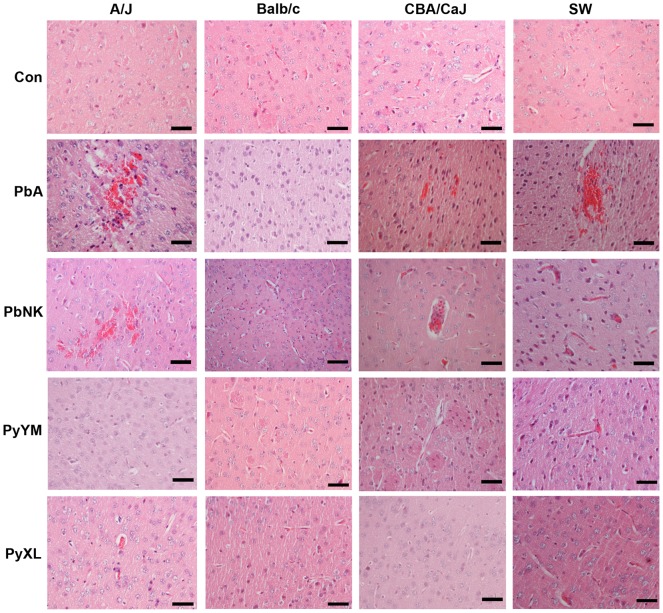
Histopathology of P. berghei and P. yoelii infection in different mouse strains.Representative images of brains from groups of 3 A/J, Balb/c, CBA/CaJ, or SW mice, infected with PbA, PbNK, PyXL, or PyYM, as well as uninfected control brains were paraffin embedded and sections stained with H&E. PbA and PbNK infection caused focal vascular congestion and hemorrhages throughout the gray and white matter in the brains from A/J, CBA/CaJ, and SW, but not Balb/c mice. Brains from PbA-infected mice with symptomatic ECM exhibited congested microvessels containing leukocytes, which were restricted to the vascular lumen. Other than rare foci of large numbers of iRBC, the microvasculature of PyXL- or PyYM-infected brains exhibited no histological alterations in any of the mouse strains compared to uninfected controls. All images derive from coronal brain sections at Bregma and correspond to neocortical layer I tissue. Scale bars = 50 µm.